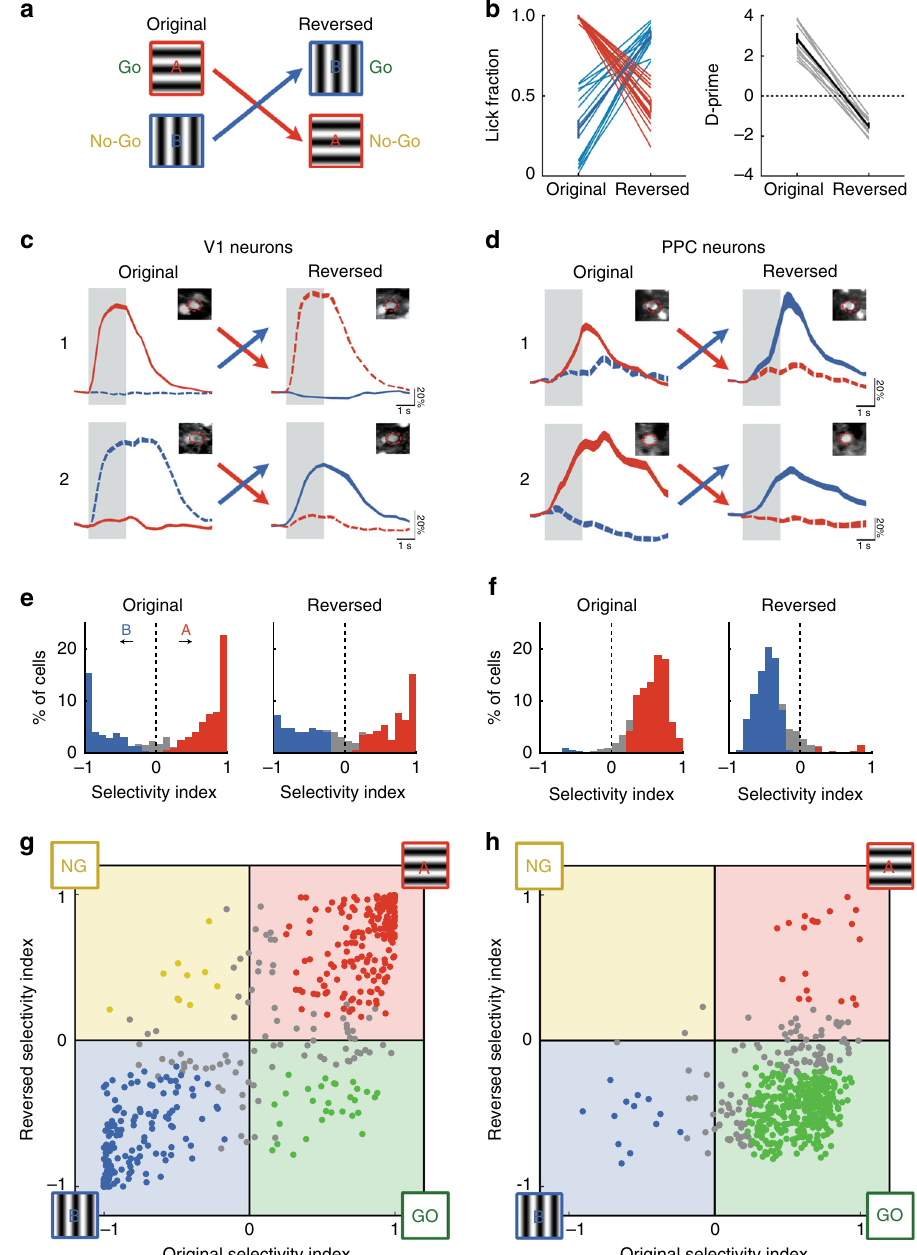
Fig 7 PPC re fl ects choice independent of stimulus-reward contingency. a Mice were trained on a go/no-go discrimination task with a reversed reward contingency. b Behavioral performance before and after reversal. Left, response rate for Stimulus A (red) and Stimulus B (blue). Right, d-prime assuming Stimulus A as target. Performance after reversal was signi fi cantly different from zero ( p < 0.001, Wilcoxon signed-rank test). c Neural response of two example V1 neurons before and after reversal of reward contingency. Colors indicate stimulus (red, A; blue, B) and line styles indicate whether the stimulus is target (solid) or non-target (dashed). Top row, response of a neuron selective to Stimulus A both before (left) and after (right) reversal. Bottom row, response of a neuron selective to Stimulus B. Insets indicate the average projection image before and after reversal, and ROI (dashed red line) that was used to extract the neural response. d Same as c but for two PPC neurons. These neurons show a switch in selectivity with reversal of reward contingency. e Histogram of selectivity index before and after reversal for V1 neurons with signi fi cant responses both before and after reversal ( n = 488). Positive values indicate selectivity to the original Target, Stimulus A (red). Colored bars indicated neurons with signi fi cant selectivity. f Same as e but for PPC neurons ( n = 509). g Scatter plot comparing selectivity index in V1 before and after reversal. Colored points indicate neurons with signi fi cant selectivity both before and after reversal. Neurons in the fi rst and third quadrants are stimulus-selective, as they prefer Stimulus A (red) or Stimulus B (blue) both before and after reversal. Neurons in the second and third quadrants are choice-selective, as they prefer either the Go stimulus (green) or the No-Go stimulus (yellow) in both conditions. h Same as g , but for